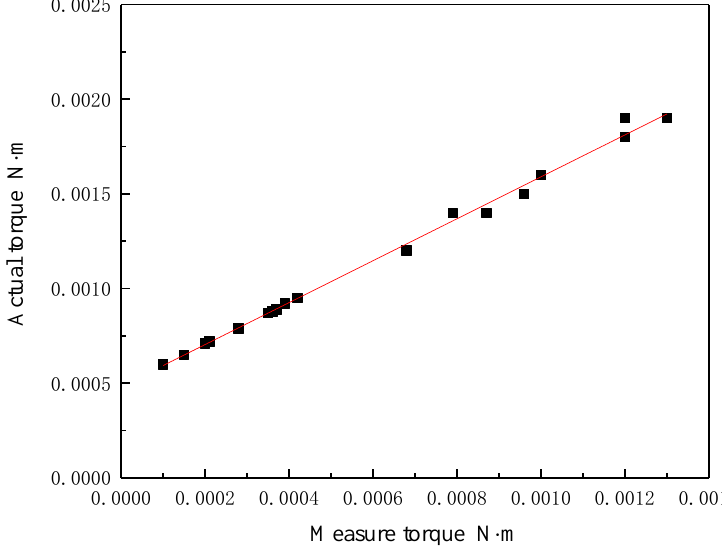
Figure 6. Torque comprehensive regression curve.